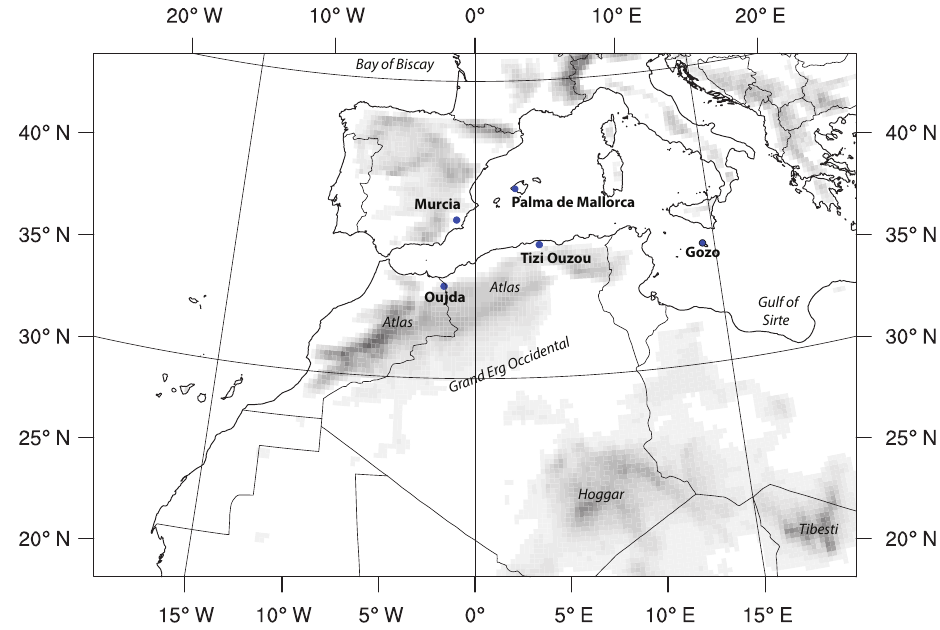
Figure 1. Overview on AERONET measurement sites considered within this study: Gozo, Malta (36.03 ◦ N, 14.26 ◦ E), Murcia, Spain (38.00 ◦ N, − 1.17 ◦ E), Oujda, Morocco (34.65 ◦ N, − 1.90 ◦ E), Palma de Mallorca, Spain (39.55 ◦ N, 2.63 ◦ E), Tizi Ouzou, Algeria (36.70 ◦ N, 4.06 ◦ E). Orography is indicated by gray